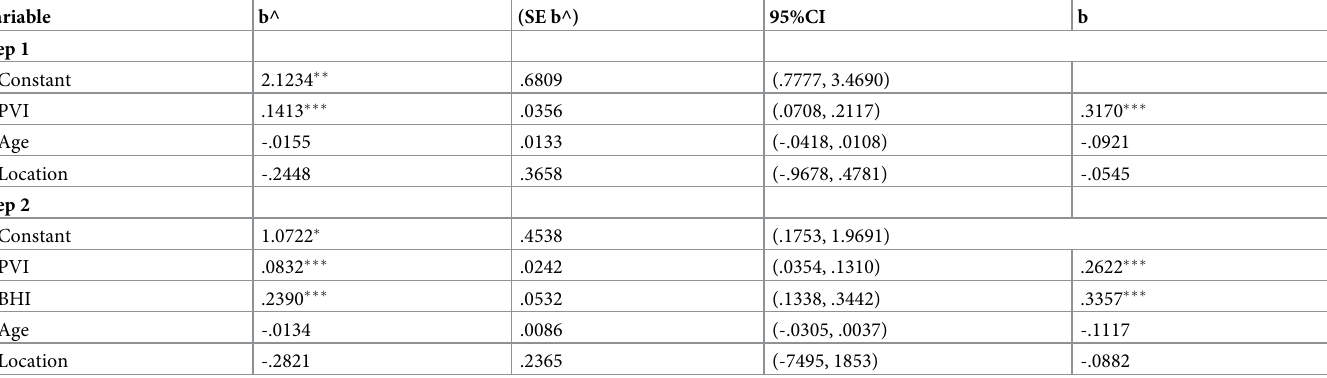
Table 6. Regression analysis for mediation of barriers to healthcare access between polyvictimization and PTSD symptom severity among the quantitative sample (N =